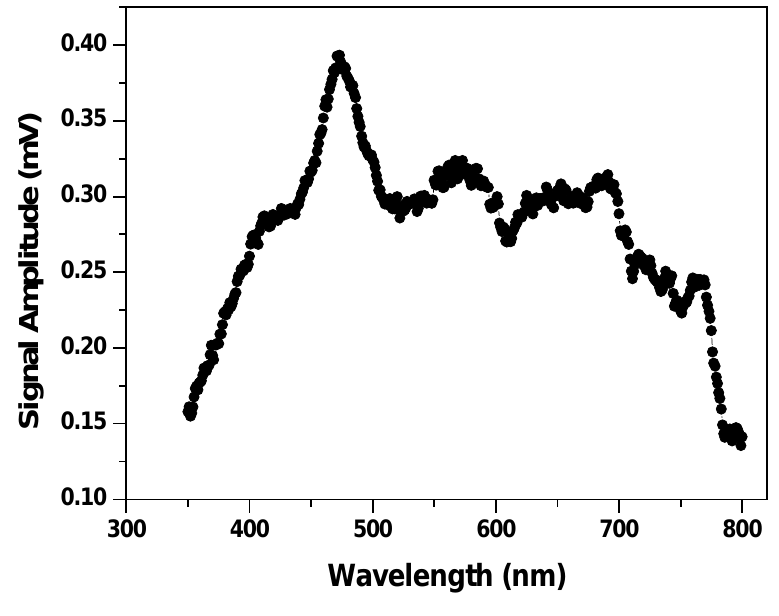
Figure 5. Reference signal amplitude obtained with the electret microphone. The curve reproduces the light intensity of the lamp as function of the wavelength, including the absorption from optical components. The maximum observed at 475 nm corresponds with the highest intensity emitted by the lamp in the wavelength range